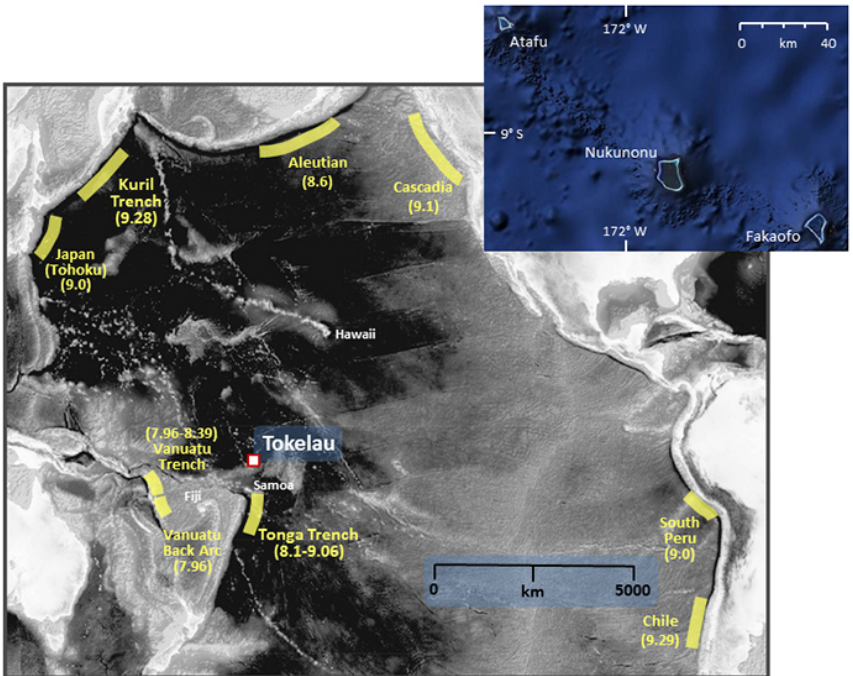
Figure 1. Location of the Tokelau Islands in the equatorial southwestern Pacific. The location of the atolls of Tokelau (Atafu, Nukunonu, and Fakaofo) are shown in the inset (base image from Google Earth). Known seismogenic sources are shown as light yellow bars, and their earthquake magnitudes used in the selected simulations herein are indicated (also summarized in Table 2 along with the fault-rupture